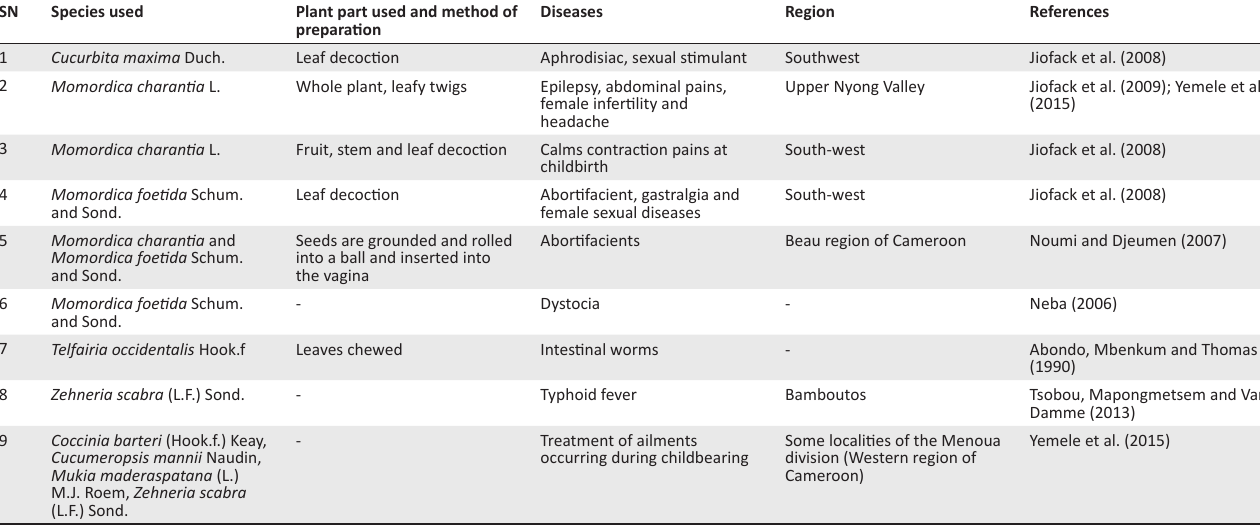
TABLE 8: Cucurbitaceae species used as traditional medicine in Cameroon. SN Species